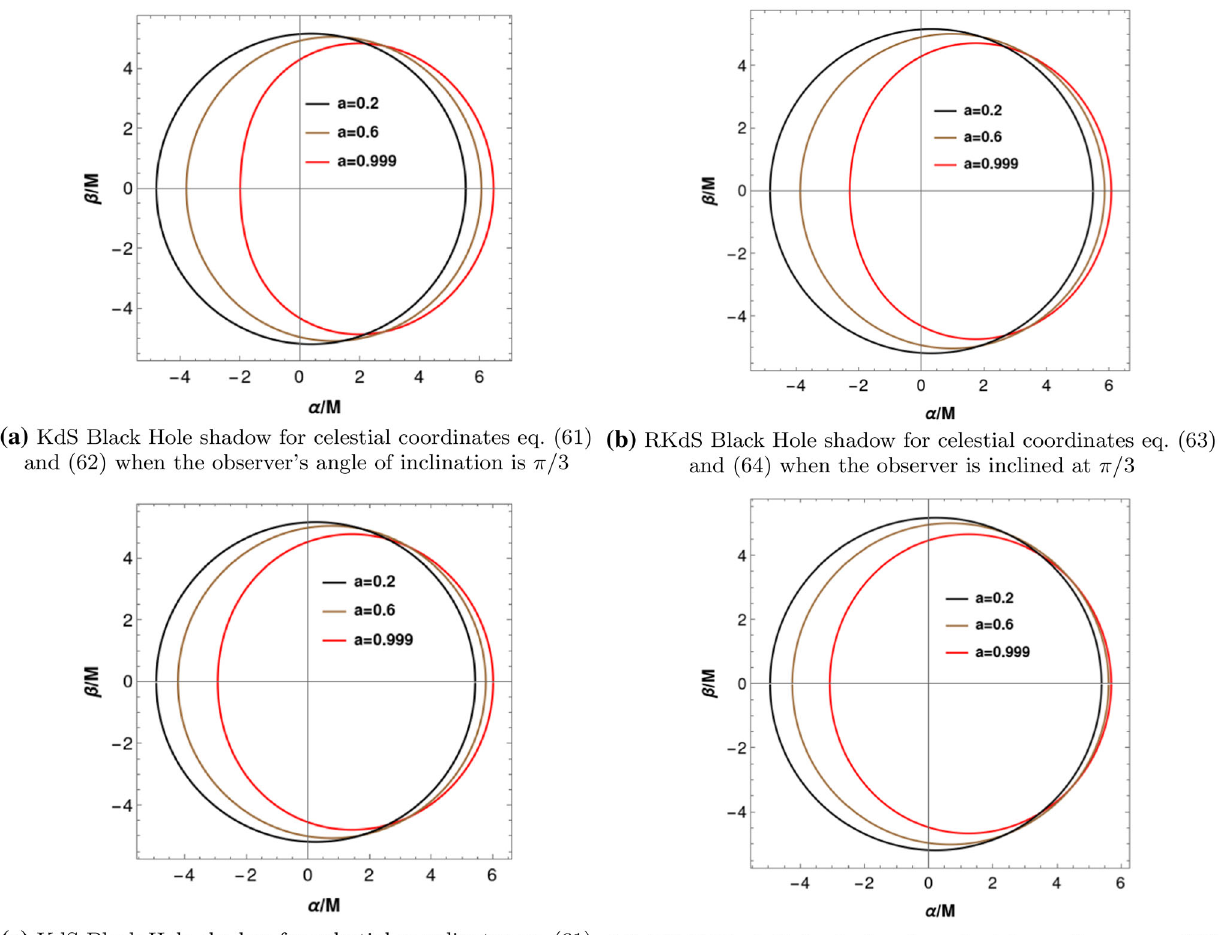
Fig. 8 Plots for different values of black hole spin when the observer’s inclination is away from the equatorial plane. M = 1 . 06 and (cid:2) = 0 . 06 m − 2